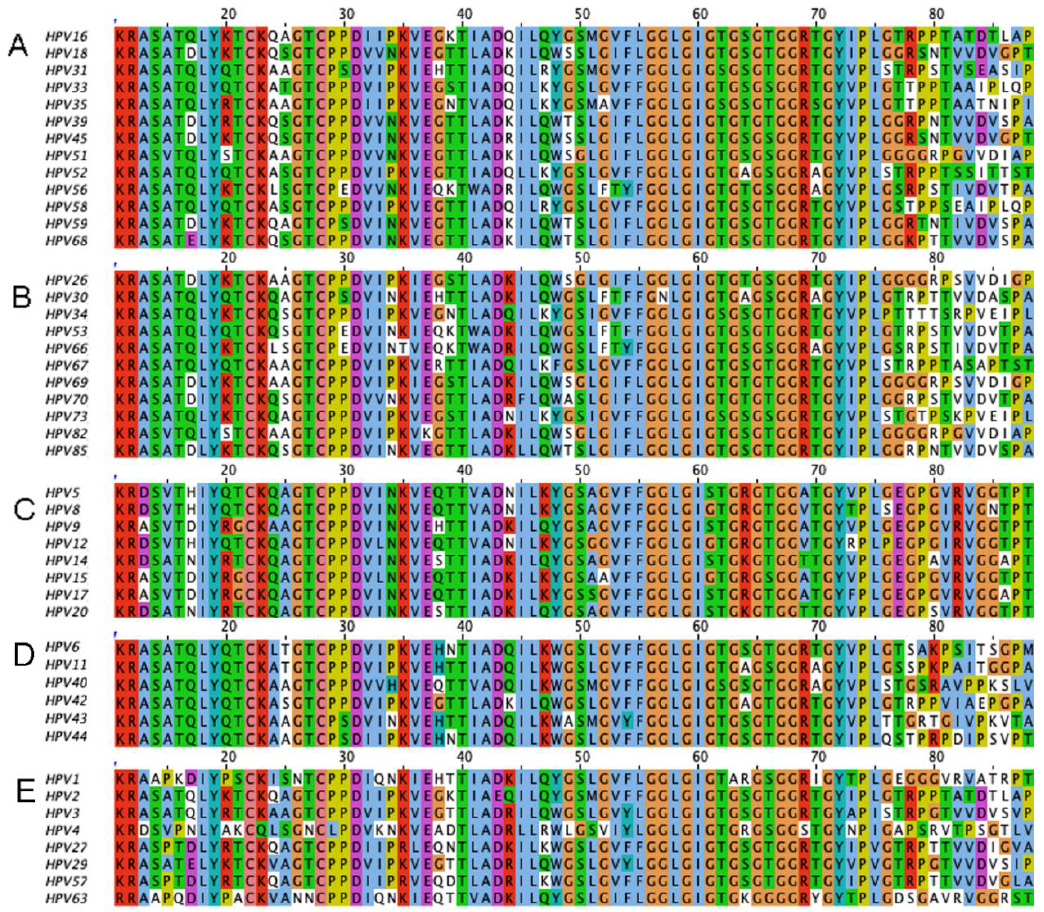
Figure 1. ClustalX sequence comparison of the highly conserved protective 11–88 epitope of HPV L2 minor capsid protein within groups associated with di ff ering diseases and oncogenicity. The alignment was generated using Jalview 2.11.1.0. (http: // www.jalview.org / ). The default color scheme for ClustalX was used. Each of the residues is assigned a color if the threshold percentage of particular amino acids in the column was met. The following colors are assigned to the categories of amino acids: blue (hydrophobic), red (positive charge), magenta (negative charge), green (polar), pink (cysteines), orange (glycines), yellow (prolines), cyan (aromatic), white (unconserved). The aligned sequences start at the furin cleavage site conserved at the amino terminus of all L2 proteins including ( A ) High-risk alpha HPV types, ( B ) Intermediate-risk alpha HPV, ( C ) EV beta types, ( D ) Genital wart-relevant alpha types, ( E ) Benign skin wart